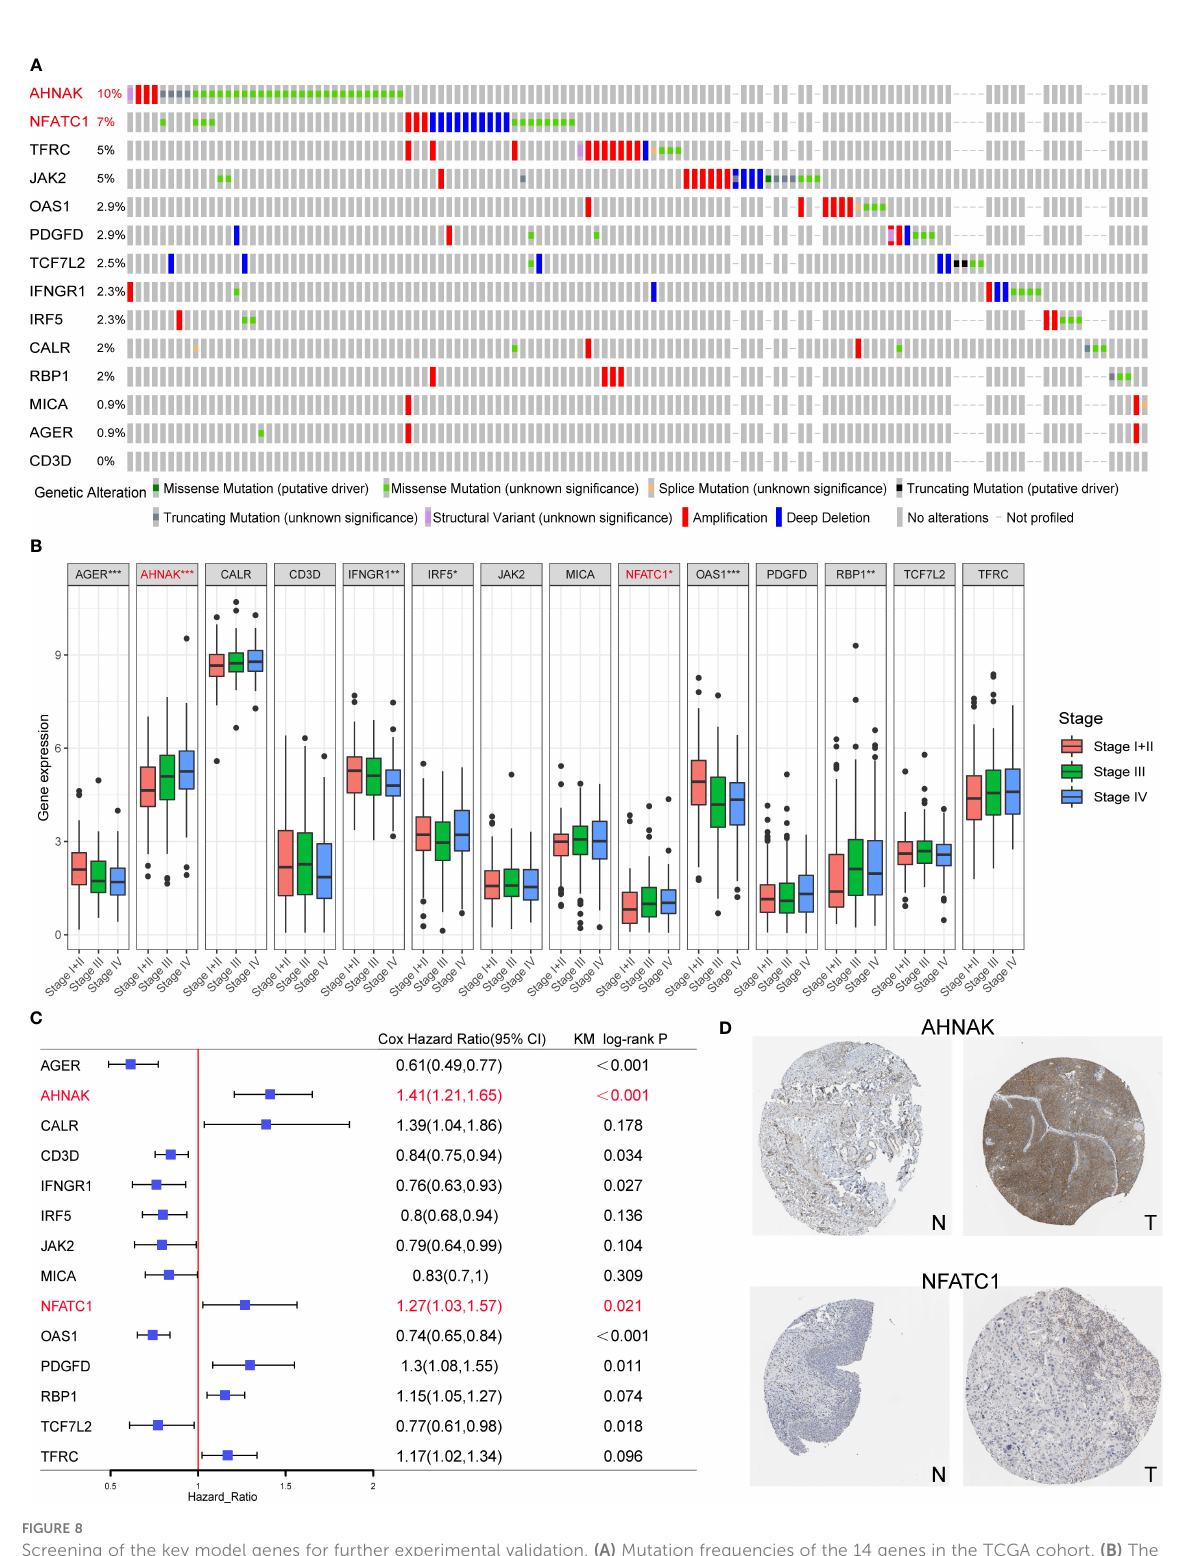
FIGURE 8 Screening of the key model genes for further experimental validation. (A) Mutation frequencies of the 14 genes in the TCGA cohort. (B) The correlation between the 14 genes and clinical stage of TCGA BLCA patients. (C) The results of univariate Cox and KM survival analyses for the 14 genes. (D) Expression levels of AHNAK and NFATC1 in cancerous and normal tissues. N, normal; T, tumor. *p<0.05, **p<0.01,